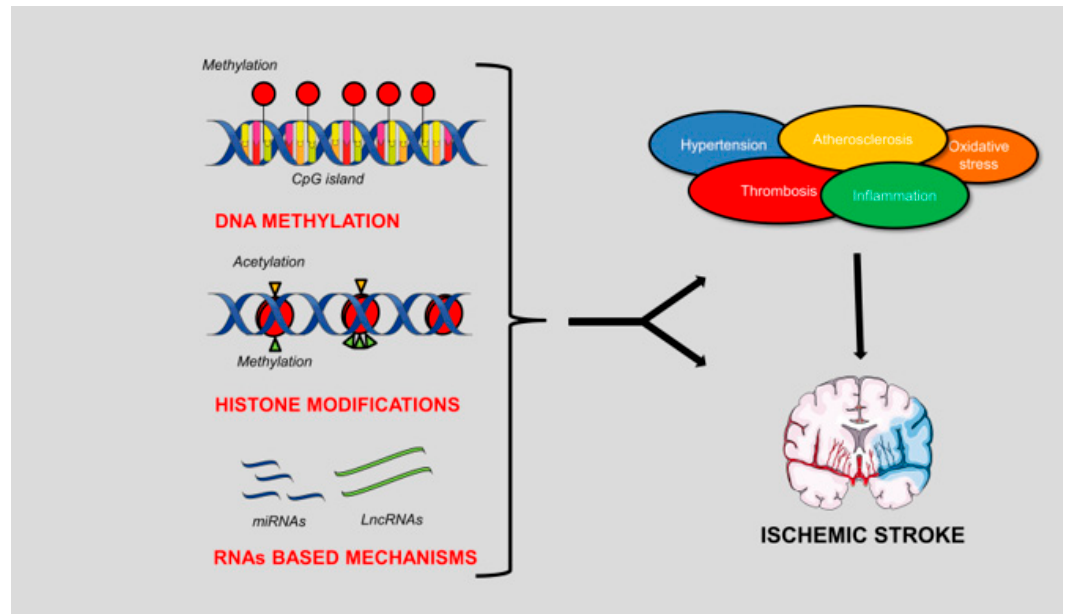
Figure 1. Schematic representation of the epigenetic mechanisms involved in the pathogenesis